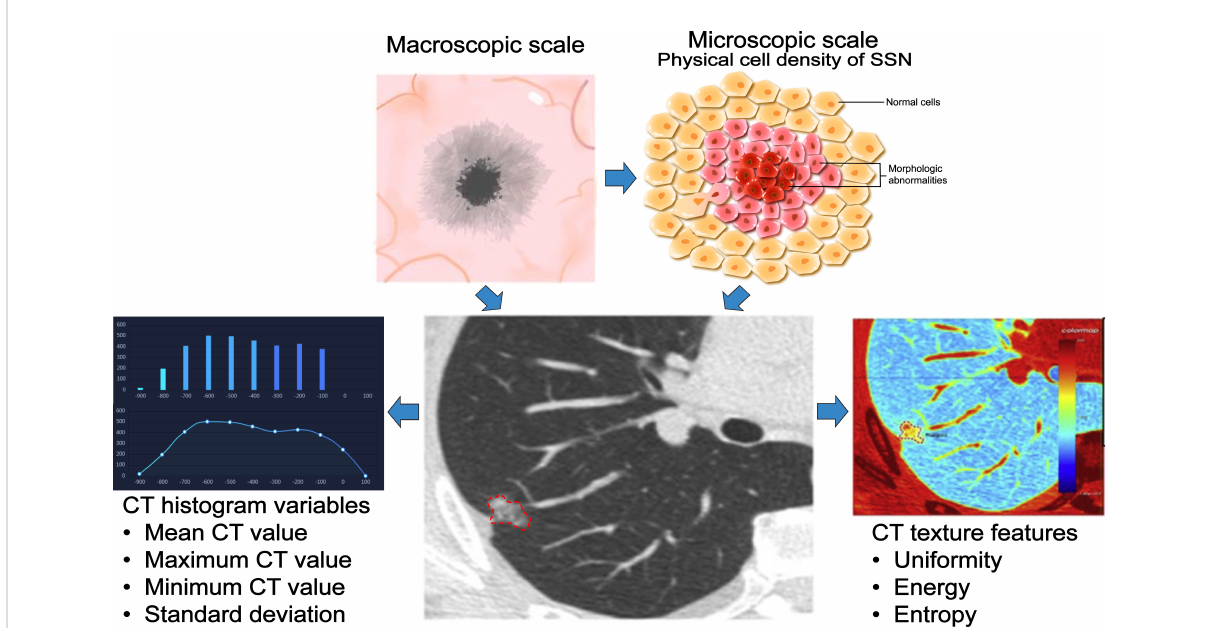
FIGURE 3 Application of three-dimensional measurement index in SSN. The performance of the SSN is determined by the physical cell density and atypia, and the CT value can re fl ect the physical cell density of the SSN in a macroscopic form. With CT manifestations, SSNs growth can be predicted based on CT histogram (mean CT value, maximum CT value, minimum CT value, standard deviation of CT value) and texture features (entropy, uniformity, and energy), resulting in better management of